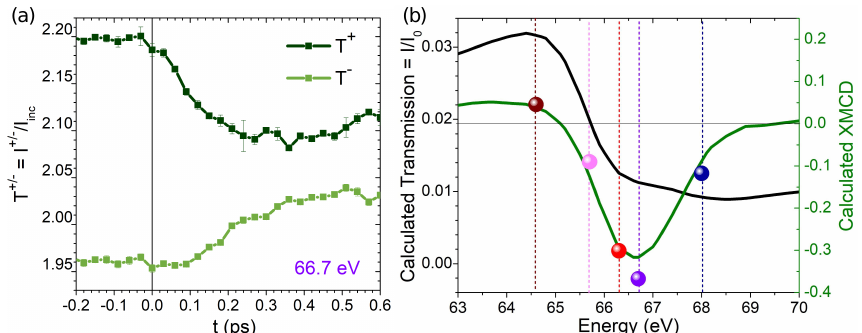
Figure 2. Characteristic pump-induced changes of T + and T − on fs timescales and static energy- dependent transmission and magnetic circular dichroism (MCD). ( a ) Transmitted intensity time traces measured for both applied field directions obtained for E = 66.7eV. ( b ) Calculated transmission (black) and MCD (green) compared with experimental static MCD (colored